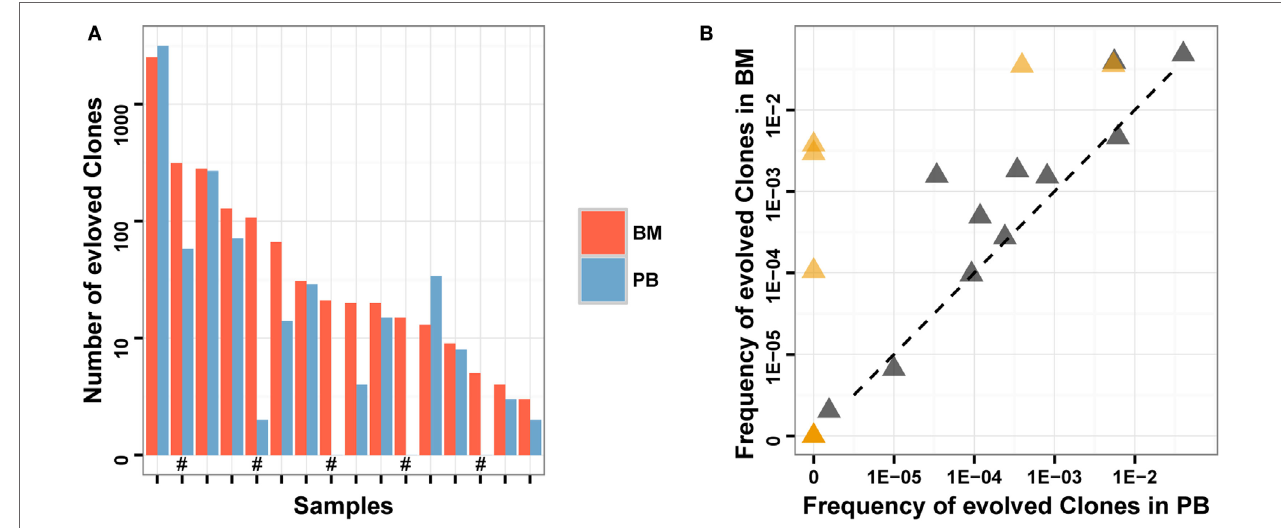
FigUre 5 | comparison of evolved clones in PB and BM . (a) The number of evolved clonotypes identified in PB and BM of the same samples. “#” in the X -axis indicates follow-up samples. (B) The total frequency of evolved clones in PB and BM of the same samples. Brown triangles indicate follow-up